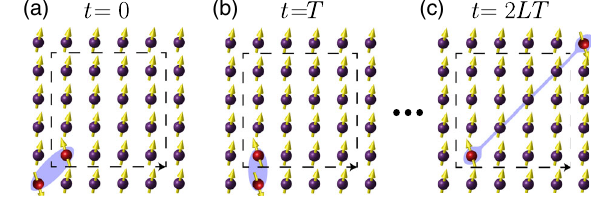
FIG. 8. Transport of quantum entanglement by the edge of a 2D bosonic MBL chiral Floquet system. The dashed line indicates schematically the separation between bulk and edge DOF, with the arrow indicating the direction of information transport along the edge. (a) Quantum entanglement (represented by the blue shaded area) is locally created at t ¼ 0 . (b,c) Entanglement is transported through a distance of O ð L Þ in time O ð LT Þ